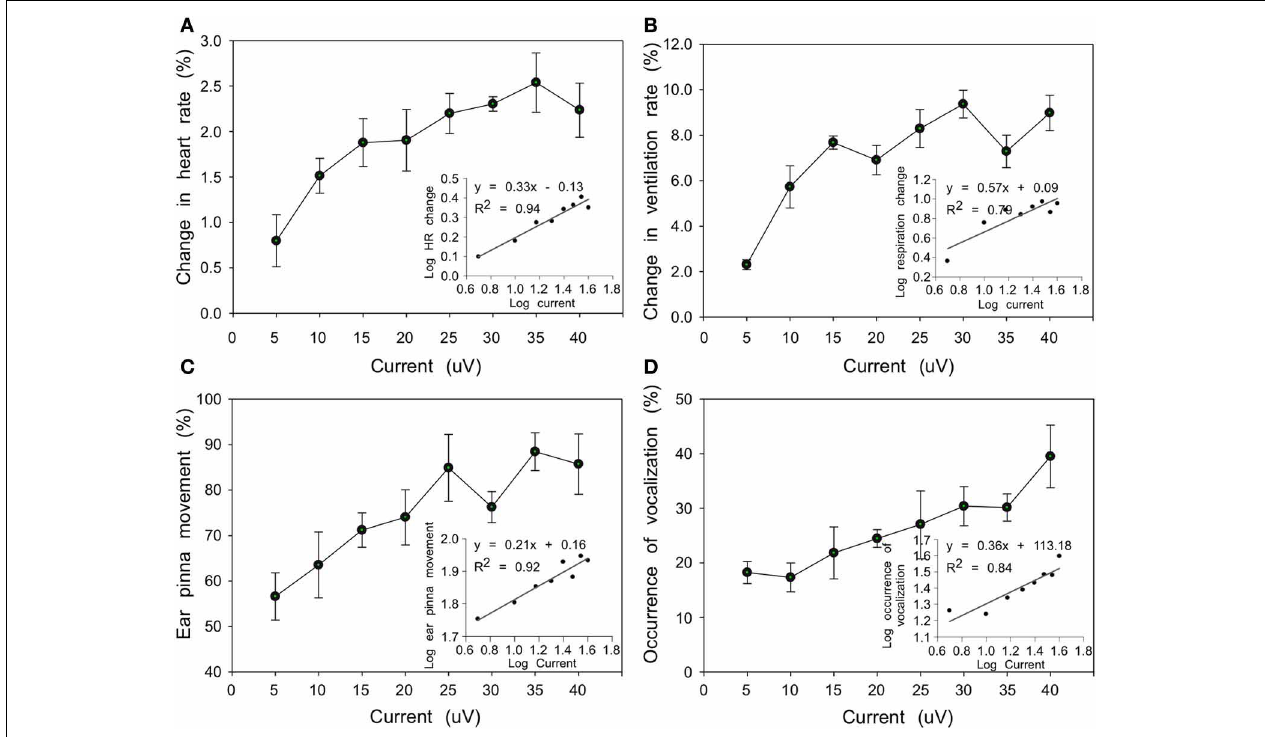
FIGURE 5 | Line plots showing relationship between current intensity and behavioral responses (A, HR; B, VR; C, PM; D, echolocation vocalizations) averaged from 4 bats. Each dot refers to the averaged behavioral responses (%) relative to the